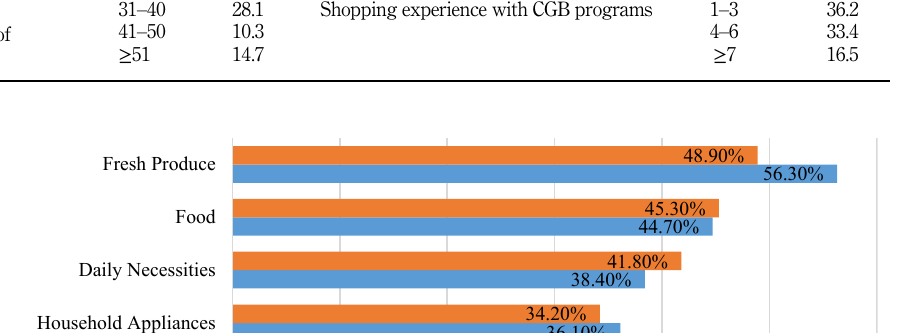
Figure 2. Distribution of shopping categories of consumers in CGB